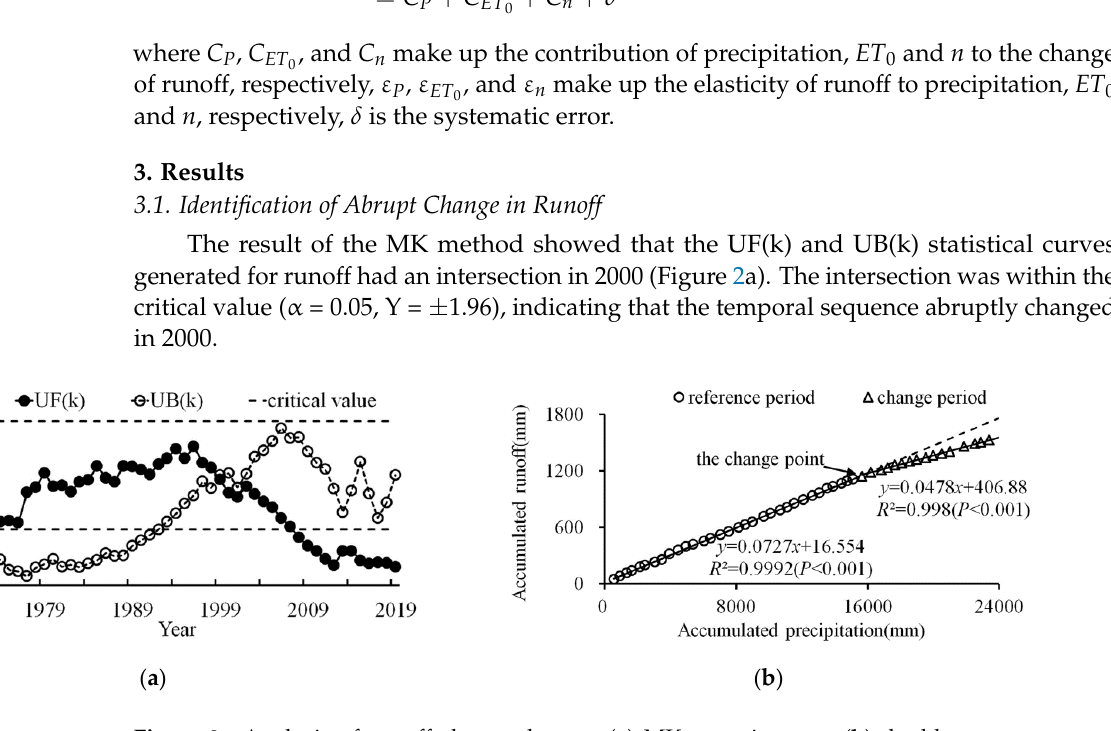
Figure 2. Analysis of runoff abrupt change: ( a ) MK mutation test, ( b ) double mass curves of precip ‐ itation ‐ runoff.